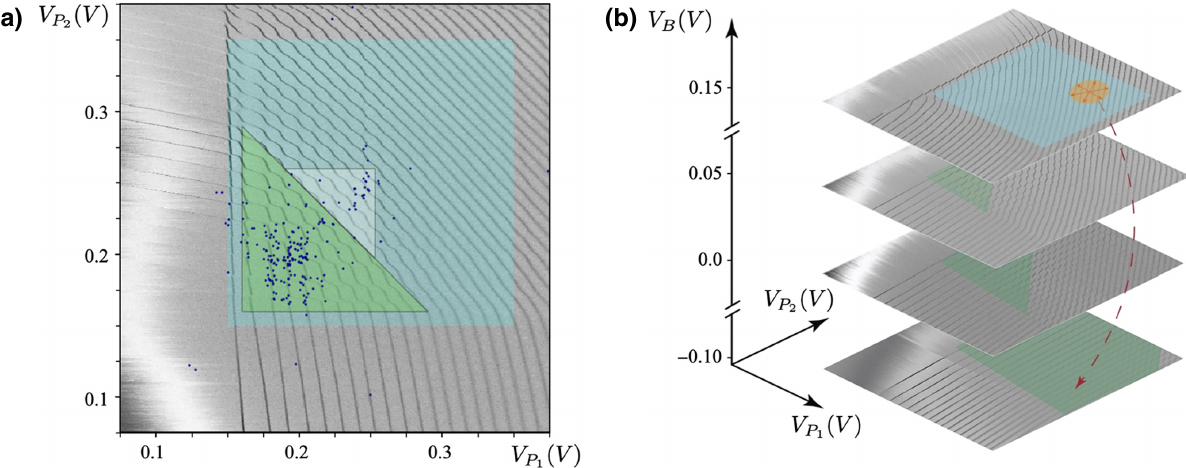
FIG. 4. (a) Scatter plot of the final state obtained in off-line tuning using the RBC framework. The tuner is set to tune to the double- quantum-dot state. We obtain a tuning success rate of 78.7%, calculated as the fraction of points that end up inside the green region, with an additional 10.2% of the points landing in an area that moderately resembles double-quantum-dot features, highlighted in white. (b) The three-dimensional space formed by 2D scans of the charge sensor response in the two plunger-gates space and the middle barrier gate. The arrow schematically shows the flow of the autotuner in the optimization loop from barrier voltages with no double quantum dot to lower voltages with a double-quantum-dot region. In both plots, the cyan square highlights the area where the initial points are uniformly sampled, while the green polygons mark the target double-quantum-dot region.